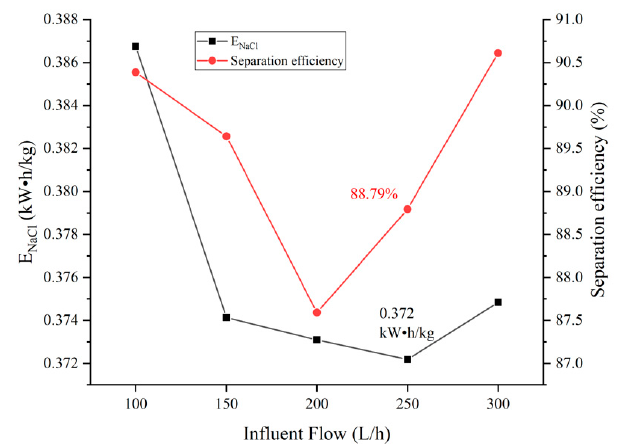
Figure 4. Influence of influent flow on the operating status of the device.